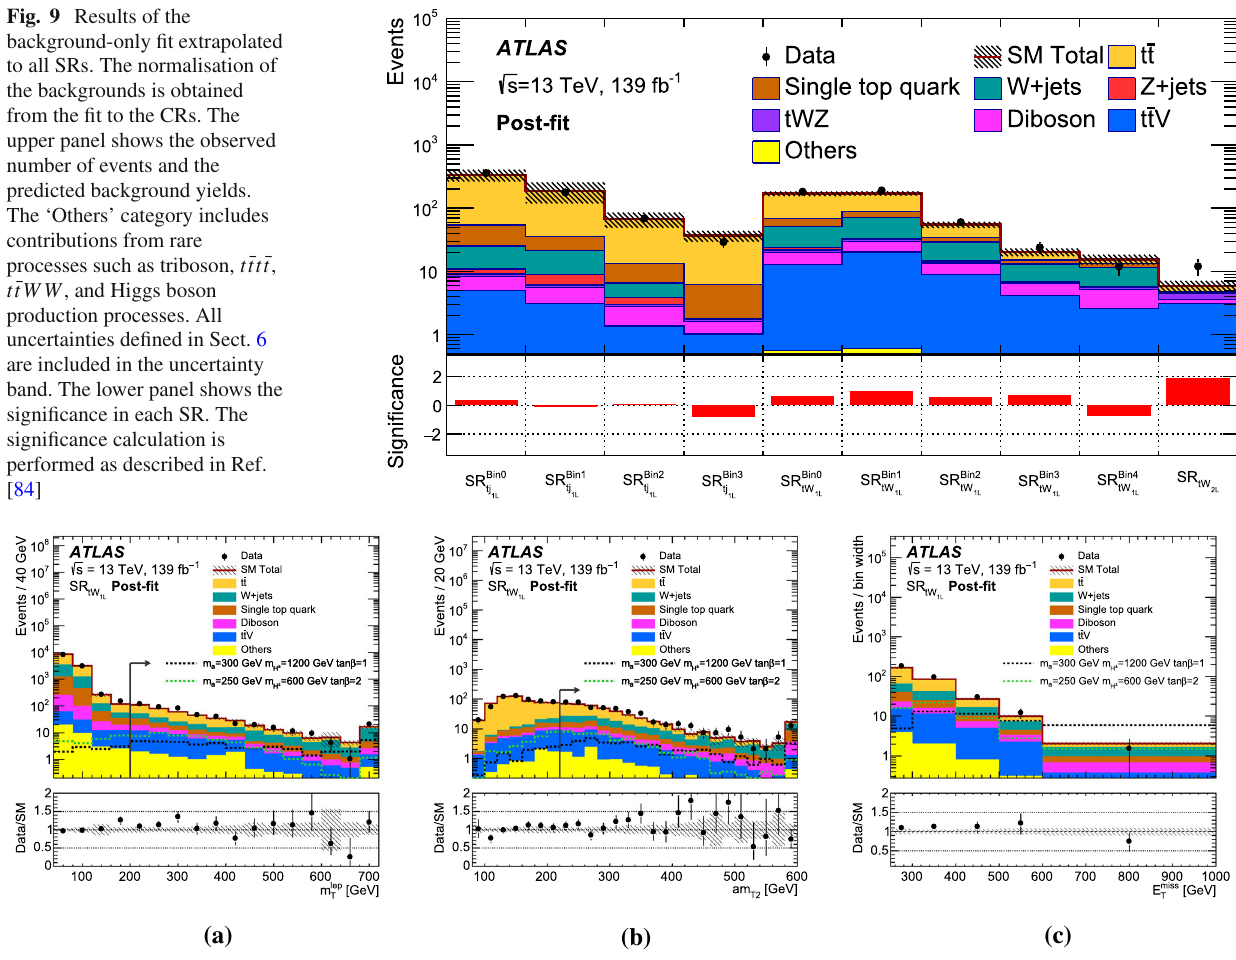
Fig. 10 Representative distributions of a m lep distributions for representative scenarios with different m a , m H ± , and , b am T2 and c E miss in T T thetW 1L channel.ObserveddataarecomparedwiththeSMbackground tan β are shown for illustrative purposes. The overflow events, where present, are included in the last bin. The lower panels show the ratio predictionsextrapolatedfromthebackground-onlyfit.AllSRselections of data to the background prediction. The hatched error bands indicate except the one on the quantity shown are applied. The SR requirement the combined experimental and MC statistical uncertainties on these is indicated by the arrow. The ‘Others’ category includes contributions background from Z +jets and tW Z production, and rare processes such as tribo- son, t ¯ tt ¯ t , t ¯ tWW , and Higgs boson production processes. The expected